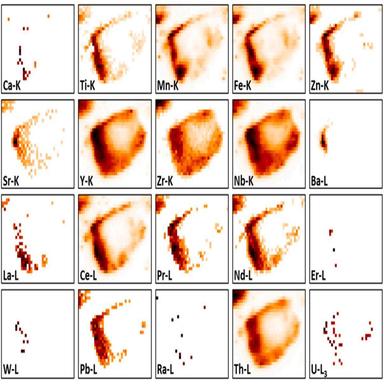
μ-XRF elemental maps of a soil particle from the Bolladalen site, showing presence of U and Ra. Map size: 1900 � 1400 μm2 map size, 50 μm step size, 1 s/pixel.